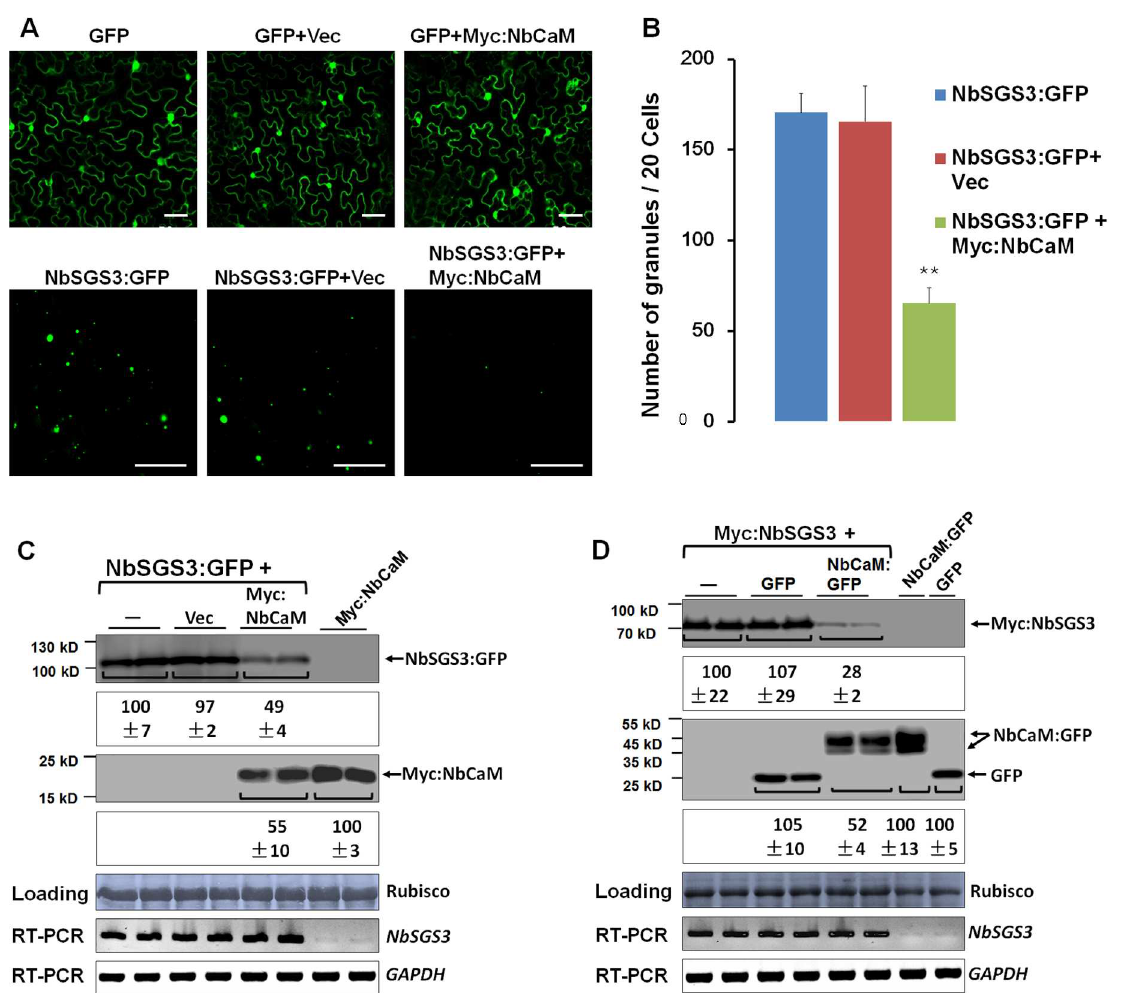
Fig 4. NbCaM reduces the number of NbSGS3 granules and mediates NbSGS3 protein degradation. (A) Micrographs showingcells expressingGFP alone, or in conjunction with an empty vector (Vec) or Myc:NbCaM (upper panel), and expressing NbSGS3:GFP alone, or in conjunction with Vec or Myc:NbCaM (lower panel). Infiltrated N . benthamiana leaves were examinedat 48 hpi. Bars represent 50 μ m. (B) The graph illustrates the averagenumber of NbSGS3:GFP granulesper 20 cells. Infiltration experiments were performed three independenttimes and 20 cells were examinedin each experiment (a total of sixty cells). Values presentedrepresent the mean ± standard deviation(SD). Doubleasterisks indicatea highly significantdifference (p < 0.01)between plant cells expressingNbSGS3:GFP alone and co-expressing NbSGS3:GFP with Myc:NbCaM (Student’s t test). (C) Western blot of total protein extracts from (B) detected with GFP (first row) or Myc (third row) antibody.Protein assays were done at least three independenttimes, and protein bandsfrom two representative experiments were quantifiedusing Image J software (second row and fourth row). The amount of proteindetected in samplesexpressingof NbSGS3:GFP or Myc:NbCaM alone was set at 100 and values under the blots represent the averagelevel of protein ± standard deviation(SD). Coomassie brilliantblue staining of Rubisco large subunitwas used as a loadingcontrol. RT-PCR was used for analysisof NbSGS3 transcripts. NbGAPDH served as an internalstandard. (D) Western blot analysisof total protein extracts from leaves infiltrated with Myc:NbSGS3 alone, or together with GFP or NbCaM:GFP. Myc (first row) or GFP (second row) antibody was used. Along with a band consistent with the expectedsize for NbCaM:GFP (48 kDa), a smaller sized protein band was also detected. This could represent different modified forms of this protein or protein degradation by protease. Protein assays were performed from at least three independent experiments, and protein bands from two representatives were quantifiedusing Image J software (secondrow and fourth row). The amount of protein detected in samplesexpressingMyc:NbSGS3, GFP, or NbCaM:GFP alone was set at 100 and values represent the averagelevel of protein ±